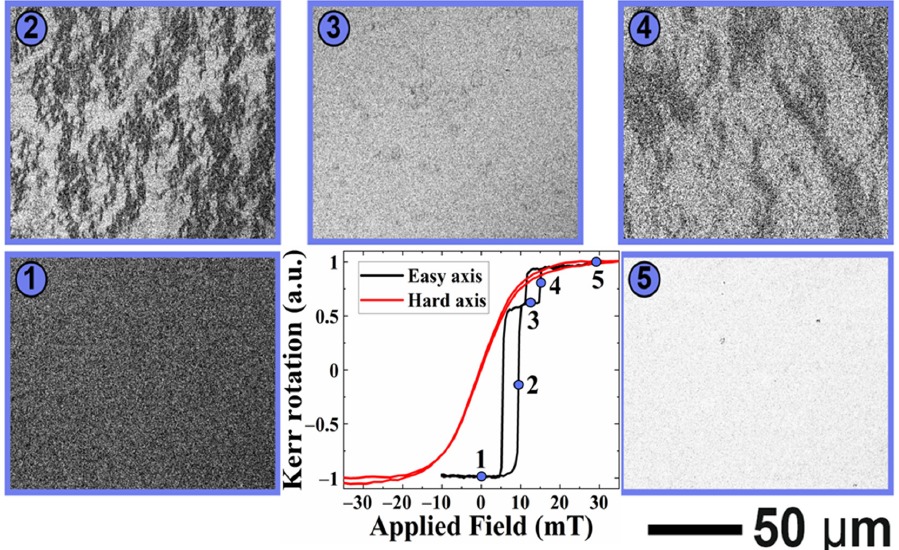
Figure 9. Magnetization reversal loop and magnetic domain evolution in tri-layer structure measured by Kerr magnetometry with the external magnetic field applied along easy axis (black curve) and along hard axis (red curve).